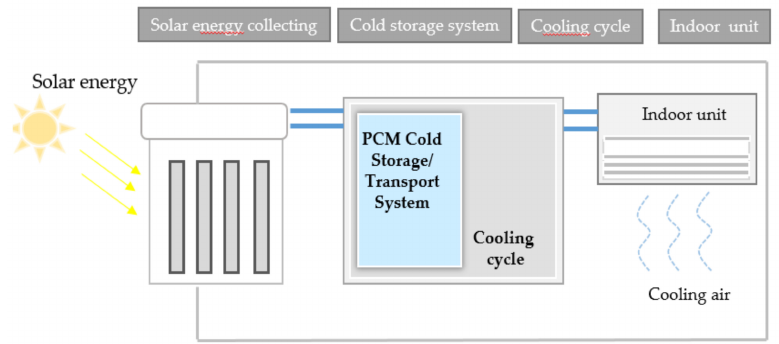
Figure 1. PCM cold storage/transportation system with solar-driven cooling cycle.